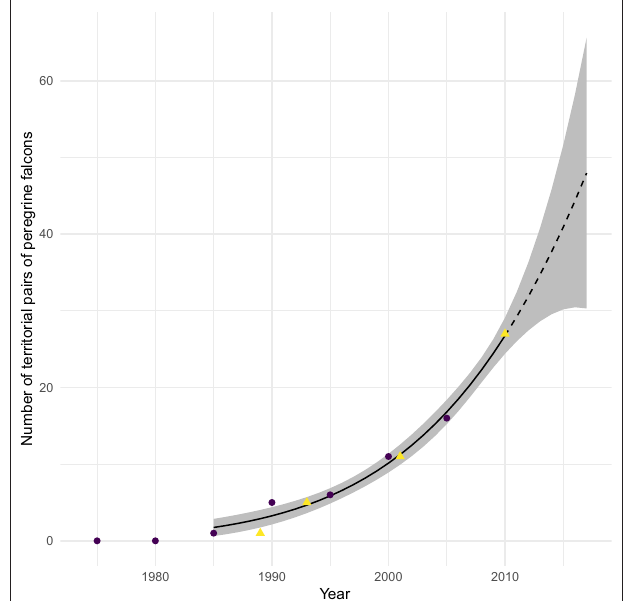
FIGURE 1 | Number of breeding pairs of Peregrine falcons ( Falco peregrinus ) in the Bay of Fundy region between 1980 and 2010. Dotted line shows the extension of the quadratic fit curve after 2010. Data from COSEWIC (2017, purple circles) and Dekker et al. (2011, yellow triangles).